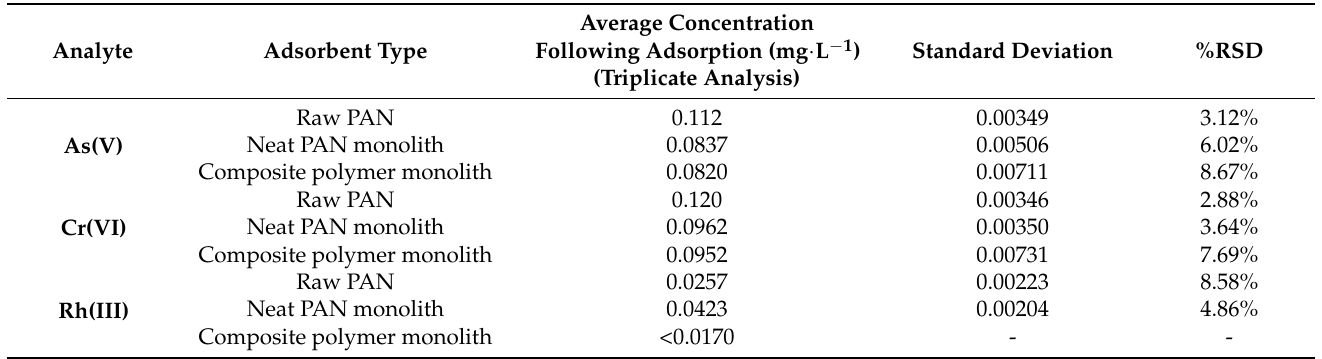
Table 3. The relative standard deviation (%RSD) values for the various recovered metal ion solutions [As(V), Cr(VI), Ru(III), Rh(III), and Pd(II)] following the adsorption studies carried out with the three polymer materials.